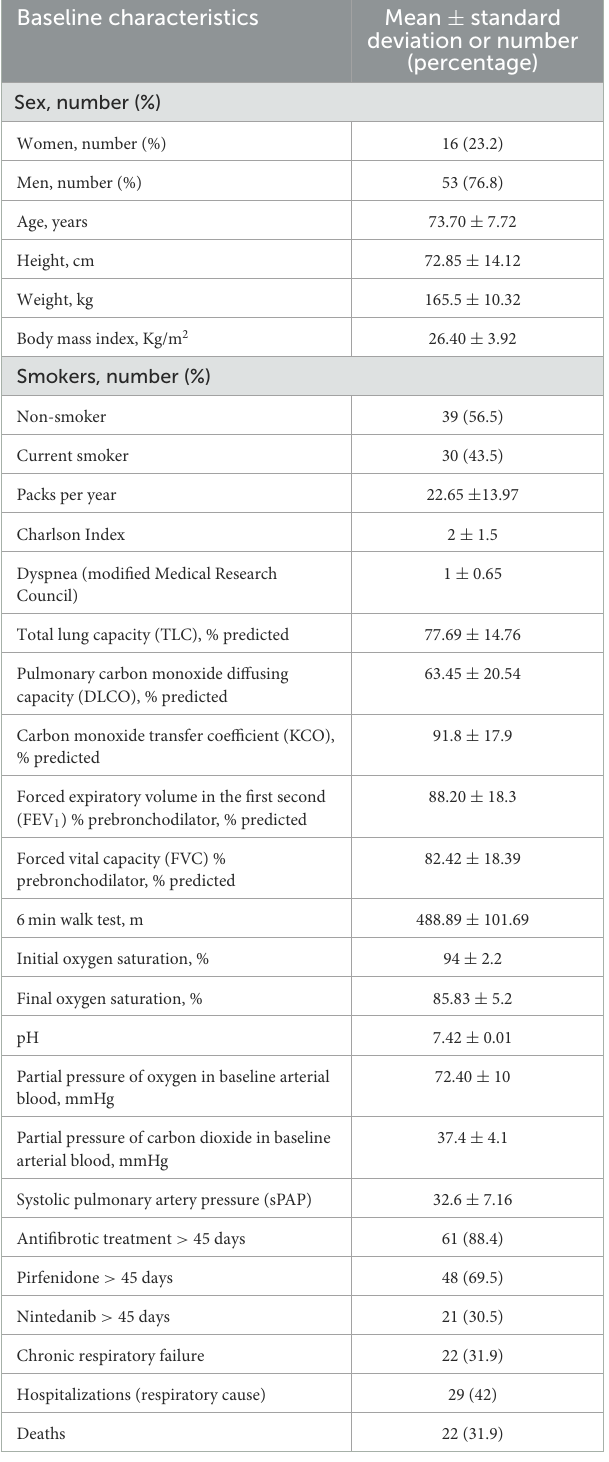
TABLE 1 Baseline characteristics of IPF